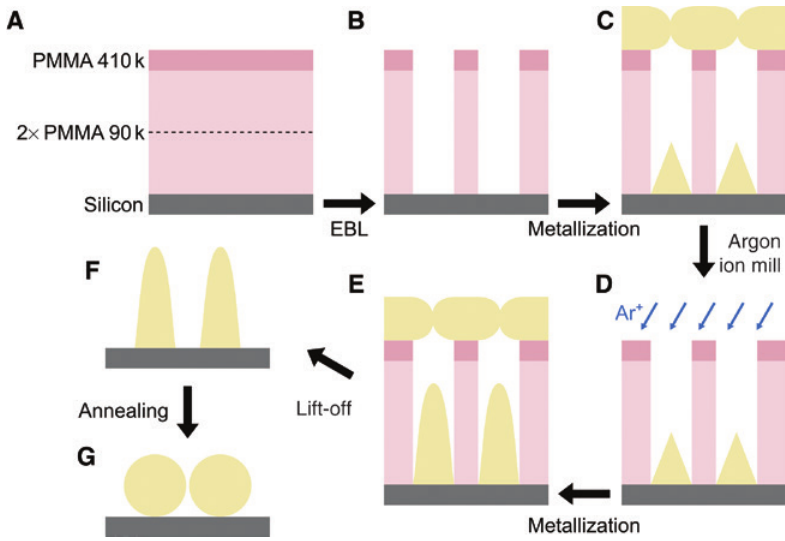
Figure 1: Sketch of the fabrication process of nano-gap spherical dimers. (A) First, three layers of PMMA with different molecular weights are spun onto a silicon substrate. (B) Electron beam lithography is used to generate patterns of nano-holes. (C) After metallization, conical structures have formed inside the holes, and the holes are closed by the metal layer. (D) The holes are reopened by using argon ion milling at an angle of 25°. (E) A second metallization increases the aspect ratio of the nano-pillars. (F) After lift-off the nano-pillars remain on the substrate. (G) Finally, rapid thermal annealing causes the nano-pillars to melt and form spheres. Hereby their gap distance shrinks compared to the initial gap distance of the pillars.